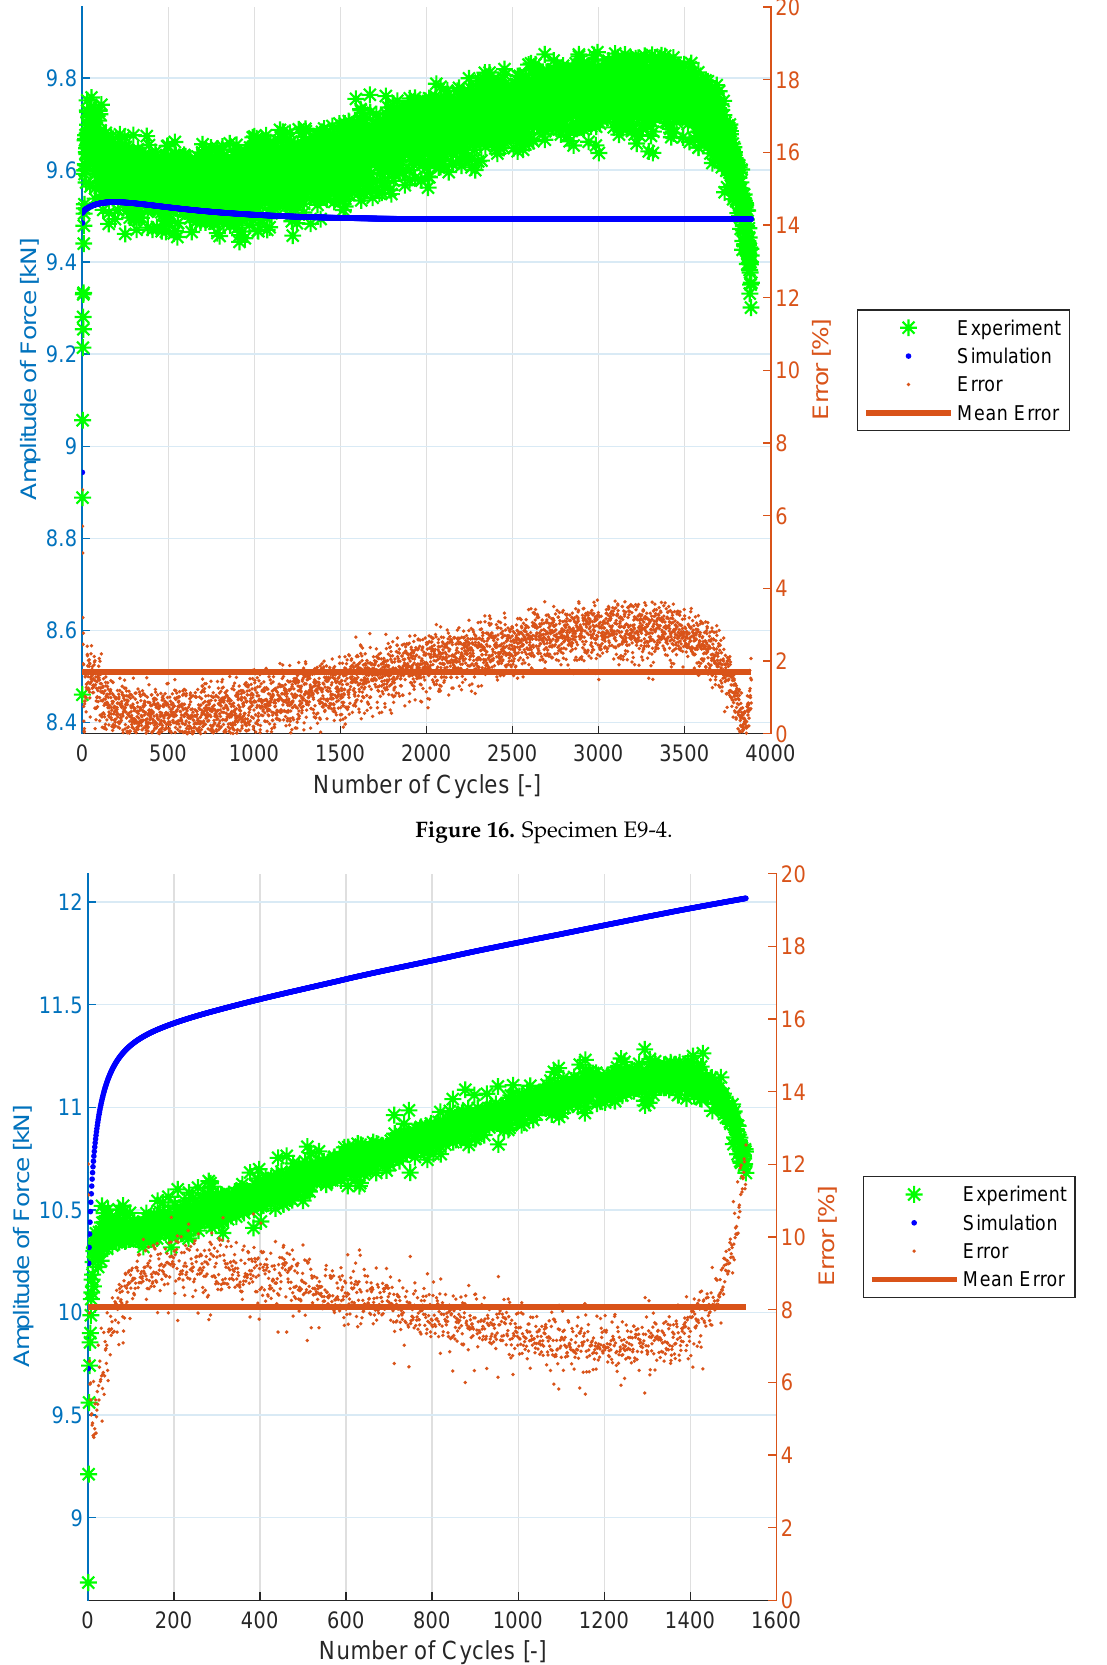
Figure 17. Specimen